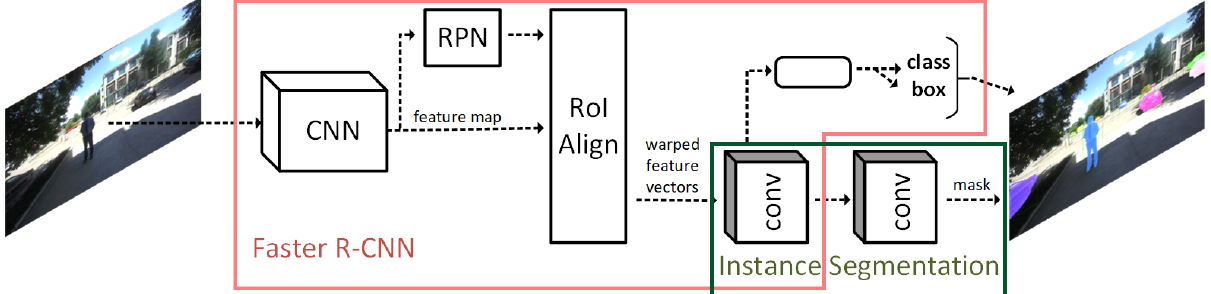
Figure 4. Mask RCNN framework for instance segmentation [3]; Mask RCNN is built on top of Faster RCNN [4] adding another branch for mask prediction. RoI Pool is replaced with RoI